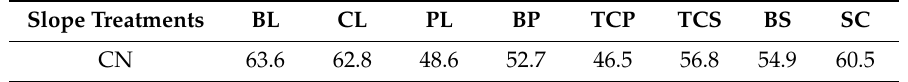
Table 2. Curve number in the SCS-CN model calibrated by runoff yields from artificial rainfall experiments.